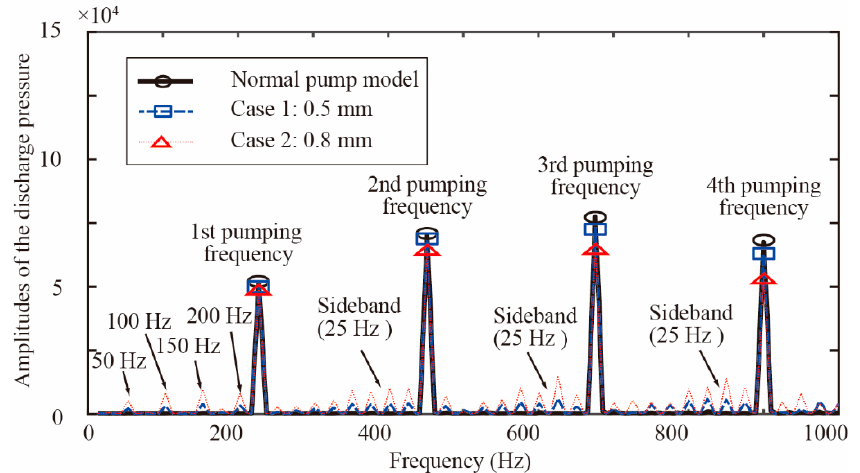
Figure 8. Spectra of the discharge pressures under different model cases.